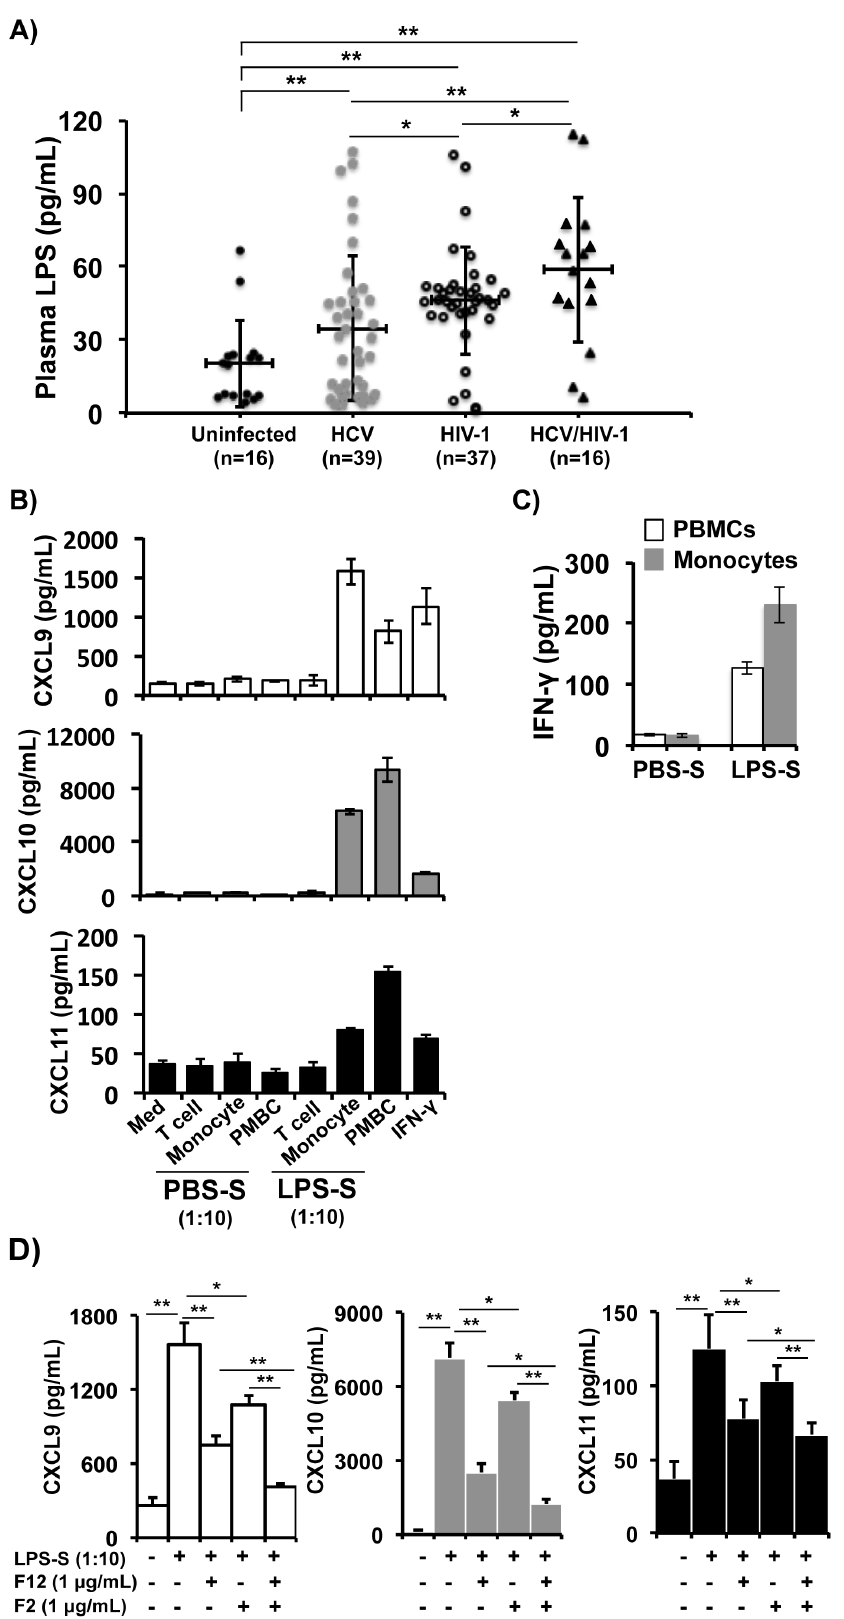
Figure 4. Indirect effect of LPS on production of CXCR3-associated chemokines by human hepatocytes. A) LPS levels in plasma from subjected uninfected, or infected with HCV, HIV-1, or HCV/HIV-1 were determined using the QCL-1000 Chromogenic LAL assay. Lines in each plot